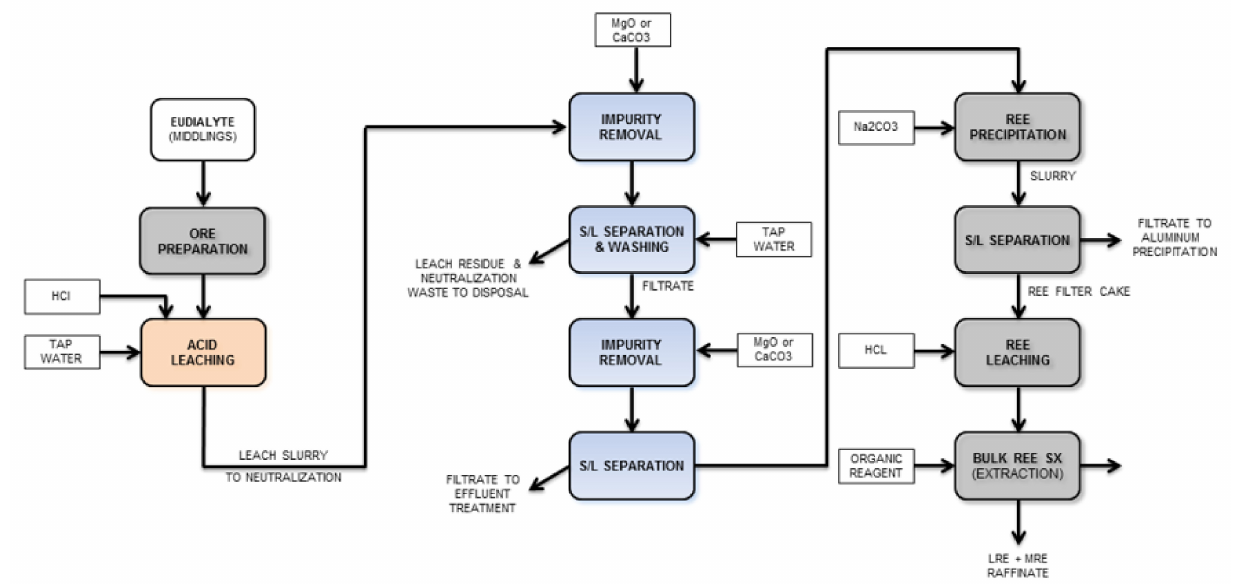
Figure 8. Treatment of eudialyte concentrate by MEAB Chemie Technik GmbH and IME, RWTH